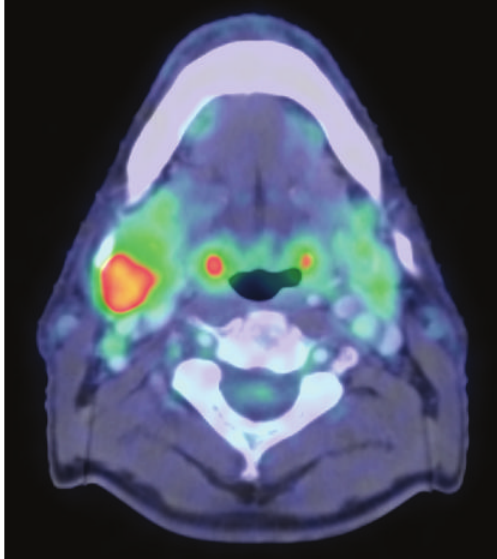
Figure 1: Axial view from fused PET/CT study demonstrates an enlarged right jugulodigastric node with heterogeneous but overall increased FDG avidity with peak SUV of 7.3.